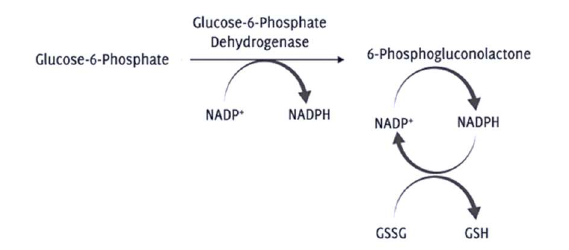
Figure 3 . Oxidative stage of Pentose Phosphate Pathway (PPP) indicating deficiency of Glucose-6-phosphate dehydrogenase leads to decreased NADPH levels. In the glutathione reduction pathway, decreased NADPH causes accumulation of GSSG (oxidized glutathione), that prevents